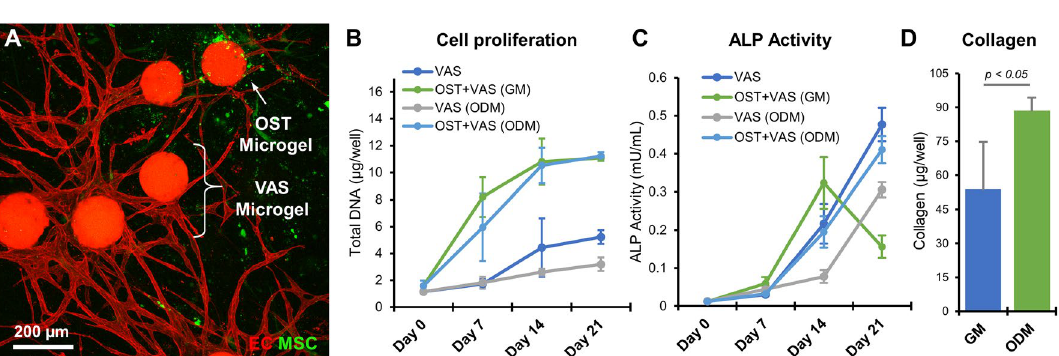
Figure 8. Hybrid constructs containing osteogenic and vasculogenic microgels. ( A ) Confocal stacks showing the endothelial sprouts (red—Ulex Europaeus Agglutinin I) and MSC (green-CellTracker Green) in hybrid microgel constructs on day 14. ( B ) Cell proliferation quantified using the total DNA content of samples at various time points. ( C ) ALP activity over time. ( D ) Total collagen deposition at day 21. (n = 3) Bar chart legend: OST-osteogenic microgel, VAS-vasculogenic microgels, GM-growth media, and ODM-osteogenic